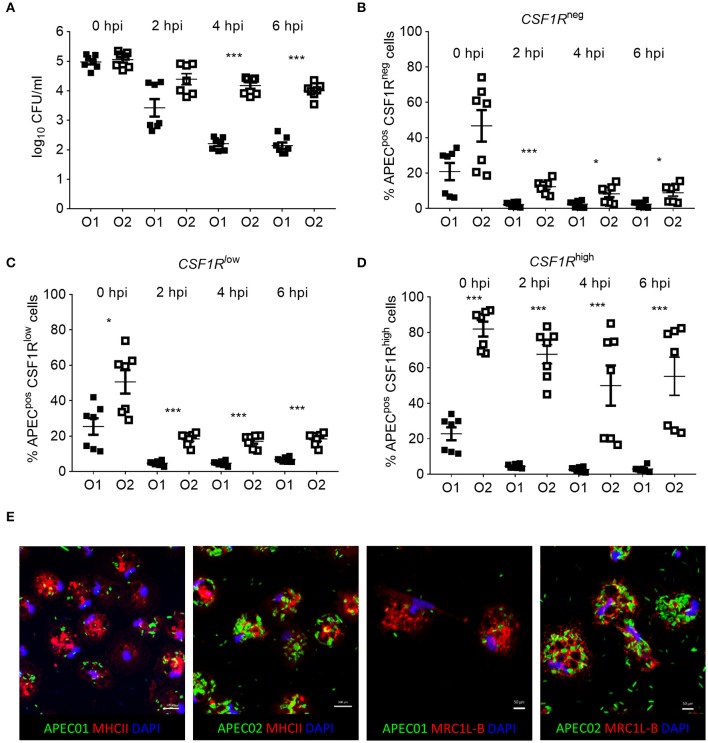
In vitro analysis of APECpos lung cells. (A) Enumeration of viable bacteria within freshly isolated gradient purified lung cells inoculated with an MOI = 10 at 0, 2, 4, and 6 hpi, (B–D) quantification of APECpos cells within the CSF1R-tgneg, CSF1R-tglow, and CSF1R-tghigh cells of the same samples by flow cytometry, and (E) visualization of APEC infection post MOI = 10 inoculation of adherent CSF1R-tghigh cells by confocal microscopy. (A–D)
n = 7 birds from two independent studies, the mean with SEM is shown, *P < 0.05, ***P < 0.001. (E) Data from one representative bird.